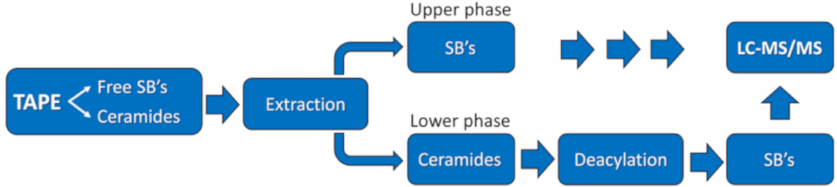
Figure 9. Scheme for determination of SBs and ceramides in the stratum corneum